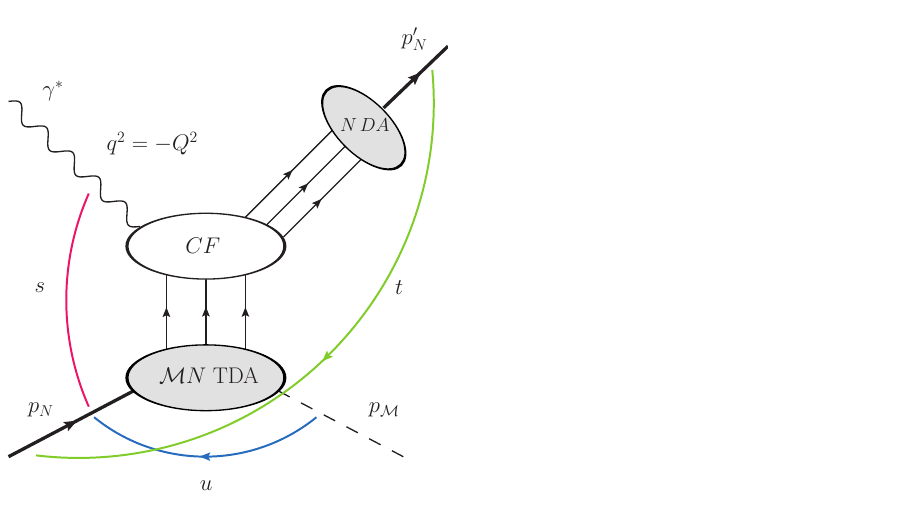
Figure 1. Kinematical quantities and the collinear factorization mechanism for γ ∗ N the near-backward kinematical regime (large virtuality Q 2 , invariant mass W ; fixed Bjorken x (or x B ); u 0). q , p N , p and p (cid:48) are the four momenta of the virtual photon probe, initial state N | | ∼ M nucleon target, final state proton, and final state meson. The lower blob, denoted the nucleon-to-meson transition distribution amplitude; the N DA blob depicts the nucleon M distribution amplitude; CF denotes the hard subprocess amplitude (coefficient function). Here, s is the center-of-mass energy squared, and t and u denote the four momentum differences squared (Mandelstam variables). These are defined as s = W 2 = ( q + p N ) 2 , t = ( p (cid:48)